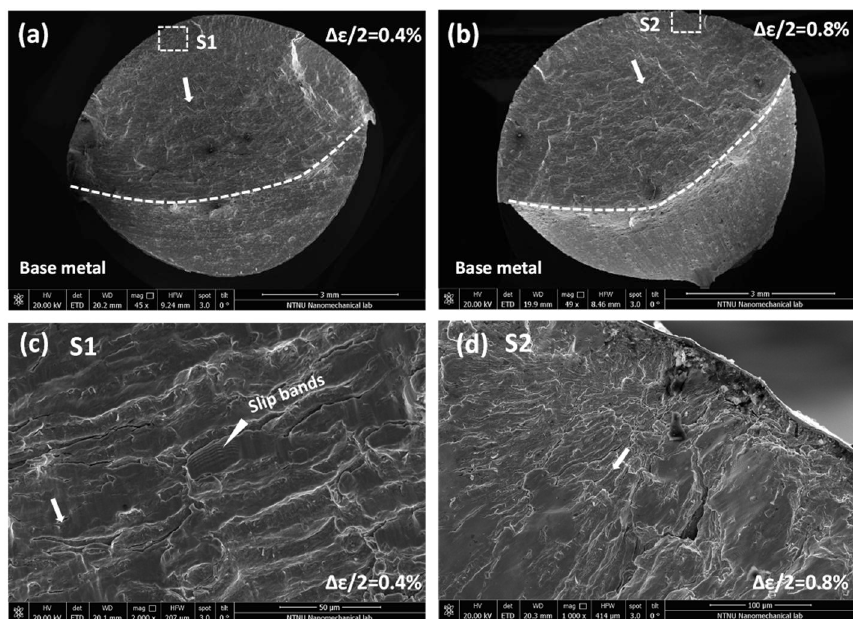
Figure 16. SEM fracture images, under strain amplitudes 0.4% and 0.8% of base metal (10NiCr3MoV). ( a ) over fracture surface under 0.4%; ( b ) over fracture surface under 0.8%; ( c ) crack propagation near crack origin under 0.4%; ( d ) crack origin under 0.4%.